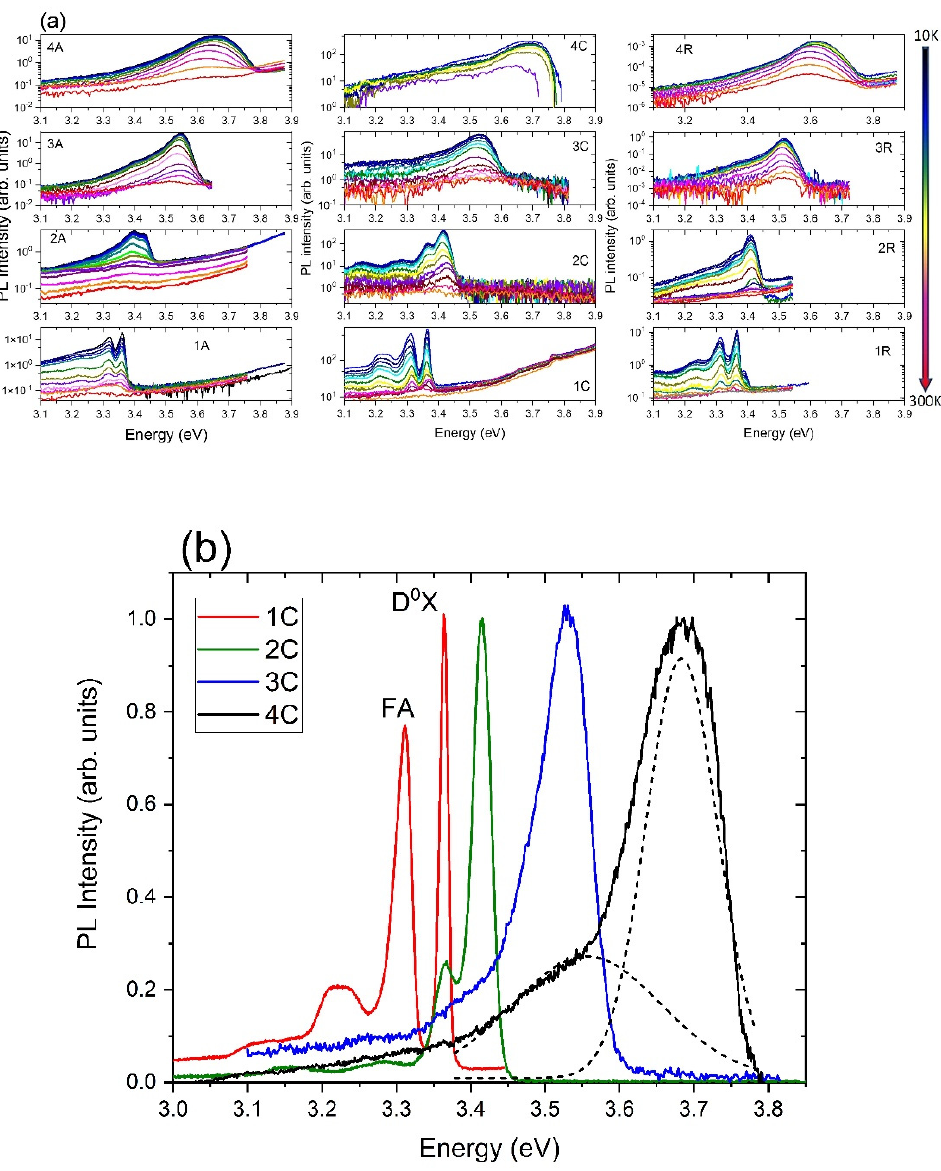
Figure 6. ( a ) Temperature dependence (10–300 K) of the Zn 1 − x Mg x O layers grown on a -, c - and r -sapphire band edge luminescence in a semi log scale. ( b ) Low temperature (10 K) normalized PL spectra of the samples 1C–4C.